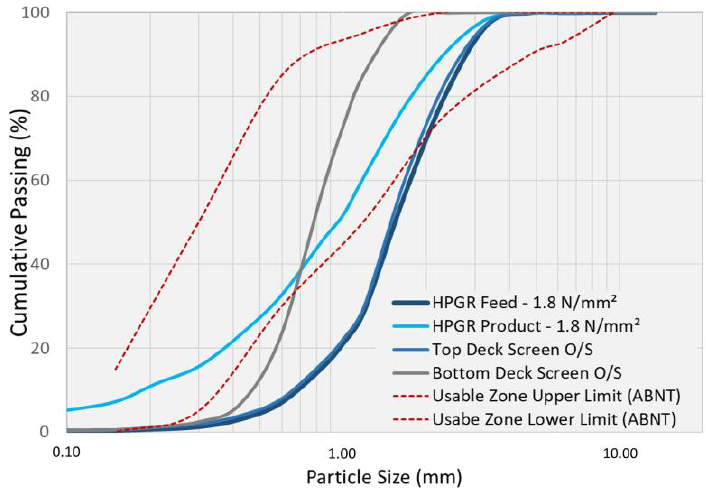
Figure 10. Survey 4 size distributions and limits for use as sand for concrete.